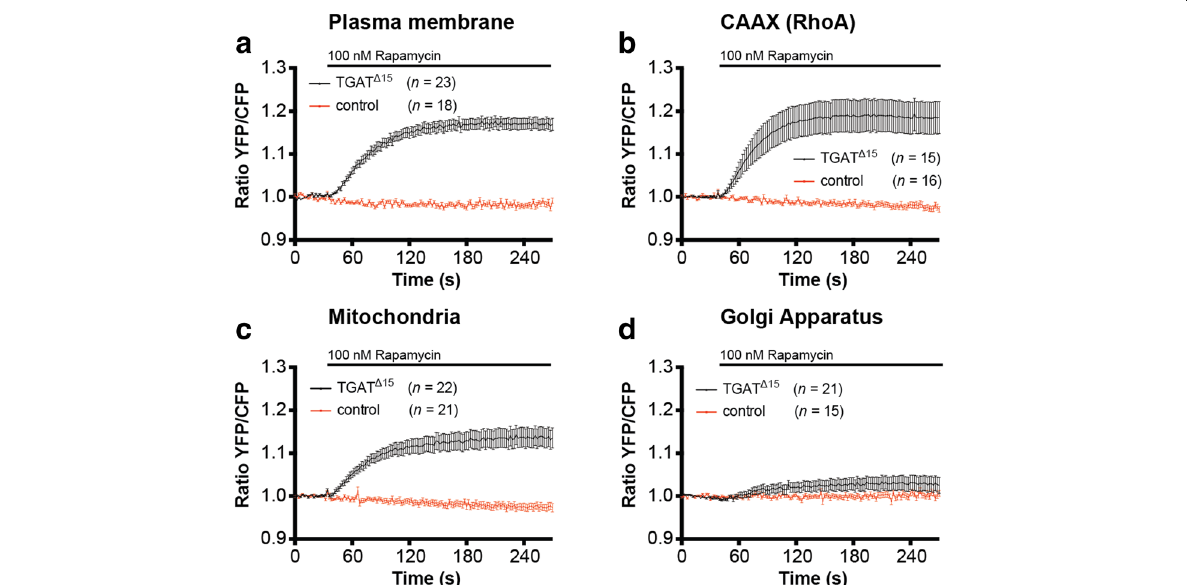
Fig. 7 Recruitment of the TGAT Δ 15 to several subcellular locations results in RhoA activation. a Hela cells transfected with the DORA-RhoA biosensor, Lck-FRB-ECFP(W66A) (plasma membrane) and RFP-FKBP12-TGAT Δ 15 ( n =23) or RFP-FKBP12 (control, n =18) were stimulated with Rapamycin (100 nM) at t =32 s. b Hela cells transfected with the DORA-RhoA biosensor, FRB-ECFP(W66A)-CAAX(RhoA) and FKBP12-RFP-TGAT Δ 15 ( n =15) or RFP-FKBP12 (control, n =16) were stimulated with Rapamycin (100 nM) at t =32 s. c Hela cells transfected with the DORA-RhoA biosensor, MoA-FRB-CFP(W66A) (mitochondria) and RFP- FKBP12-TGAT Δ 15 ( n = 22) or RFP-FKBP12 (control, n = 21) were stimulated with Rapamycin (100 nM) at t = 32 s. d Hela cells transfected with the DORA-RhoA biosensor, Giantin-FRB-CFP(W66A) (Golgi apparatus) and RFP- FKBP12-TGAT Δ 15 ( n = 21) or RFP-FKBP12 (control, n = 15) were stimulated with Rapamycin (100 nM) at t = 32 s. Time traces show the average ratio change of YFP/ CFP fluorescence